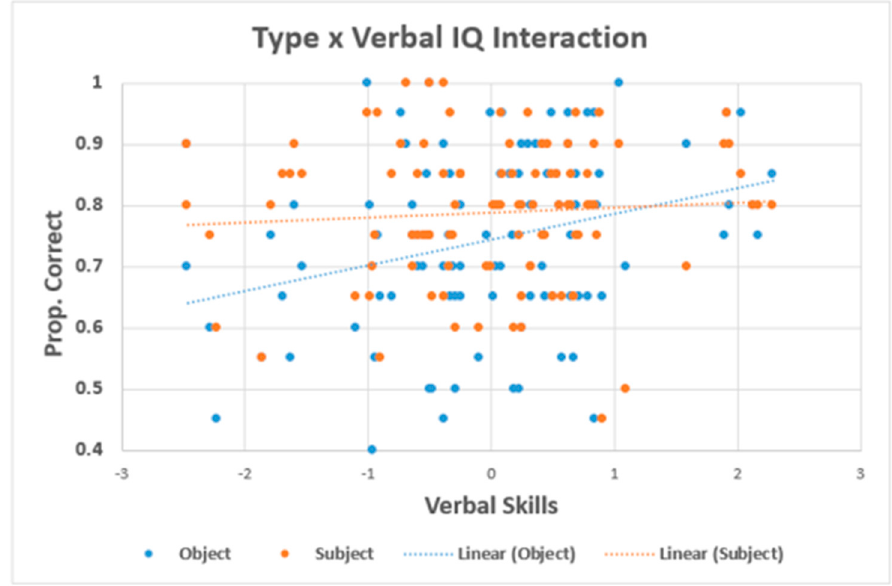
Figure 1. Mean comprehension accuracy. Error bars show the standard error of the mean. Table 4. Inferential results for comprehension accuracy .